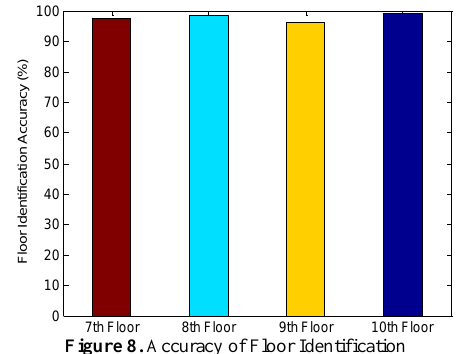
Figure 8. Accuracy of Floor Identification